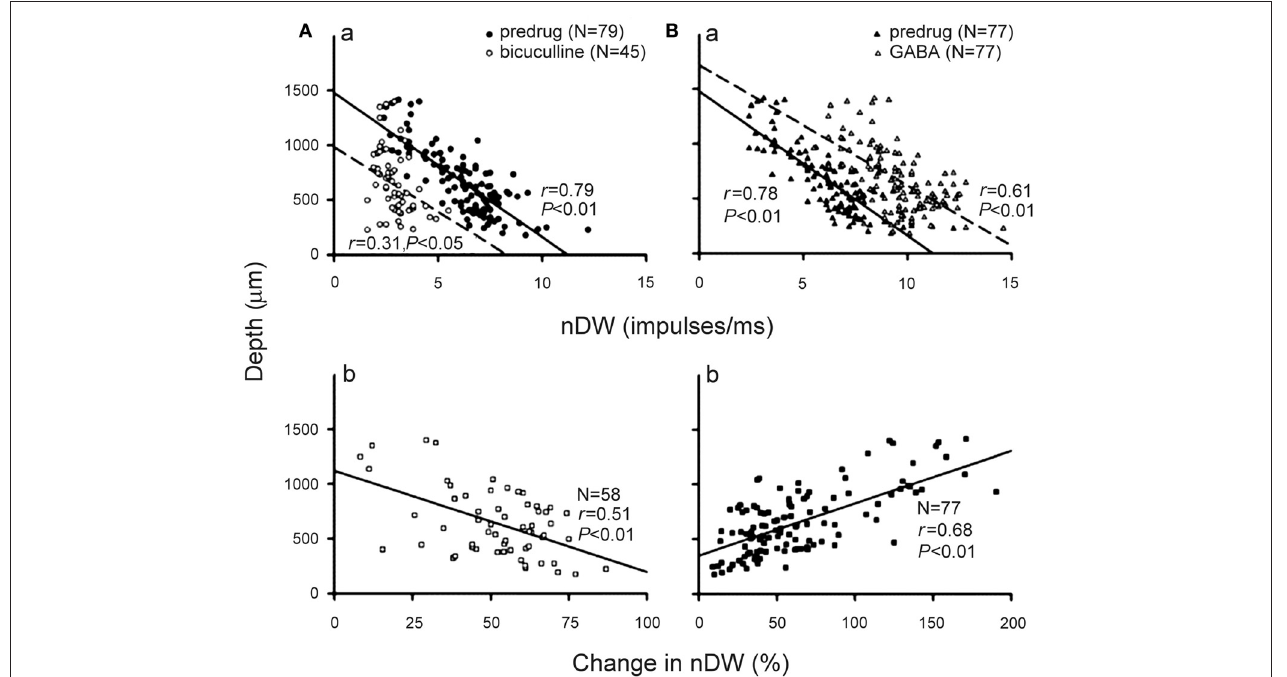
FIGURE 5 | (Aa,Ba) The distribution of nDW of collicular neurons obtained before (filled circles and triangles) and during (unfilled circles and triangles) bicuculline (Aa) and GABA (Ba) application in relation to the recording depth.